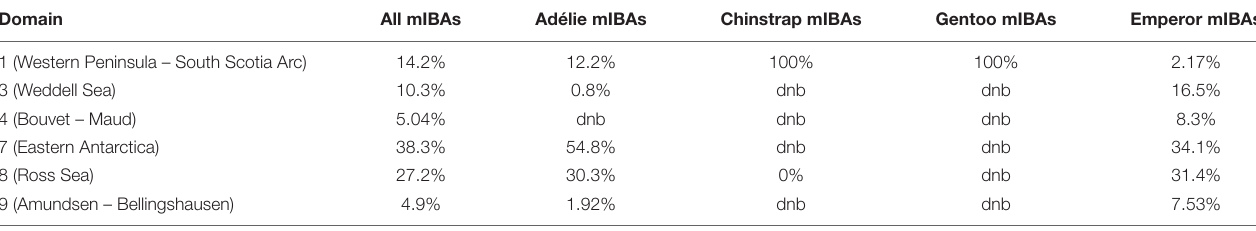
TABLE 2 | Percentage of marine IBAs in each of the MPA planning domains within given study area only. Domain